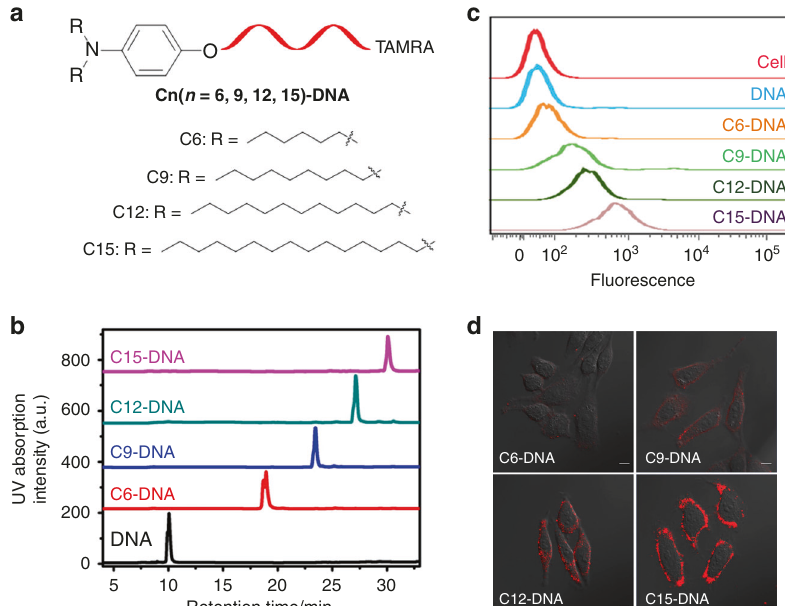
Fig. 2 Hydrophobicity-dependent cell membrane adhesion of lipid-conjugated oligonucleotides. a Schematic illustration of the structure of C6-DNA, C9- DNA, C12-DNA and C15-DNA with different alkyl chain lengths in lipid tails. b HPLC chromatograms of DNA, C6-DNA, C9-DNA, C12-DNA and C15-DNA. c Flow cytometry of HepG2 cells treated with 1 μ M TAMRA-labeled DNA, C6-DNA, C9-DNA, C12-DNA or C15-DNA. d Confocal fl uorescence microscopy imaging of HepG2 cells treated with 1 μ M TAMRA-labeled C6-DNA, C9-DNA, C12-DNA or C15-DNA. Scale bar is 10 μ m